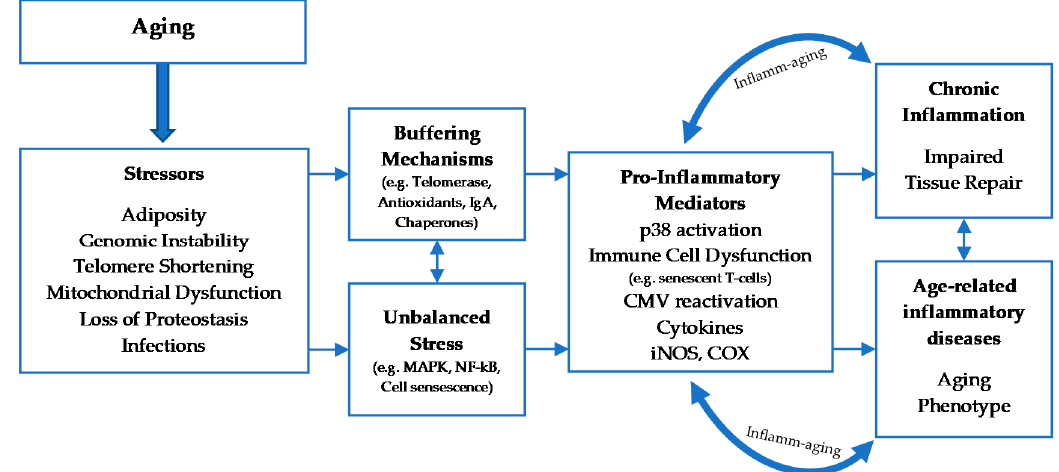
Figure 1. Mechanisms leading to a pro-inflammatory state with aging and a vicious cycle of inflamm-aging. Age-induced stressors that can potentially trigger inflammation, as well as unbalanced stress like cell senescence, are normally downregulated by buffering mechanisms. If these mechanisms fail, the existing stress leads to the production of pro-inflammatory mediators and disruption of immune cells, which is conducive to a chronic inflammation status and age-related inflammatory diseases. This then again deteriorates the inflamm-aging process in a positive feedback loop through an increase in circulating inflammatory mediators. CMV: Cytomegalovirus; COX: Cyclooxygenase; IgA: Immunoglobulin A; iNOS: inducible nitric oxide synthase; MAPK: Mitogen-activated protein kinase; NF- κ B: nuclear factor kappa-light-chain- enhancer of activated B-cells. Modified according to Bektas et al. [1] and Macaulay et al. [20].